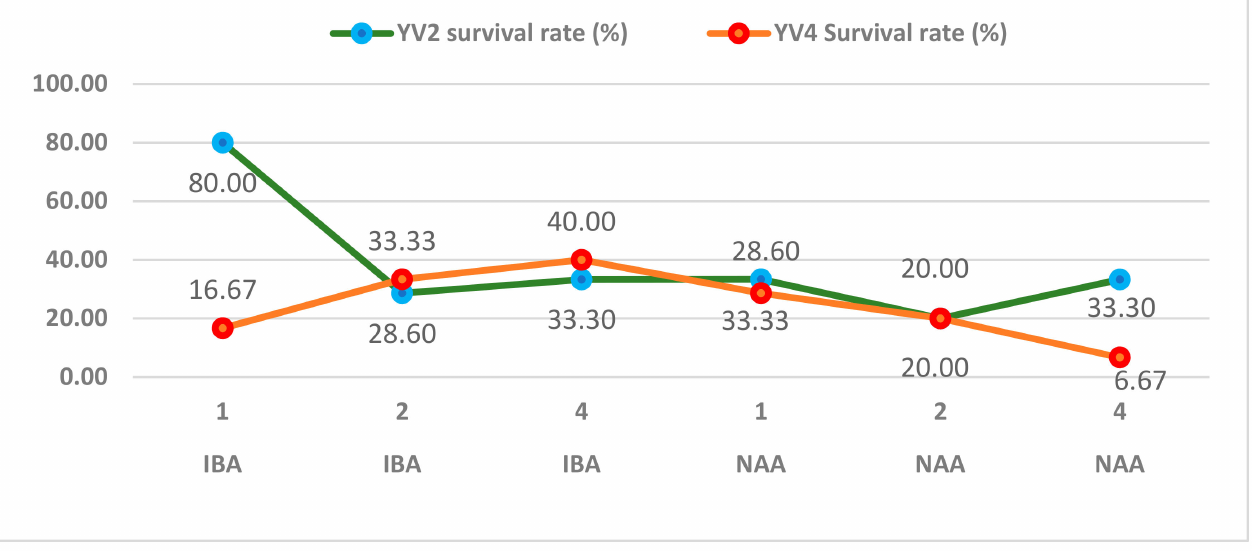
Figure 7. Survival rate of in vitropropagated YV2 and YV4 genotype plantlets at 4 weeks after